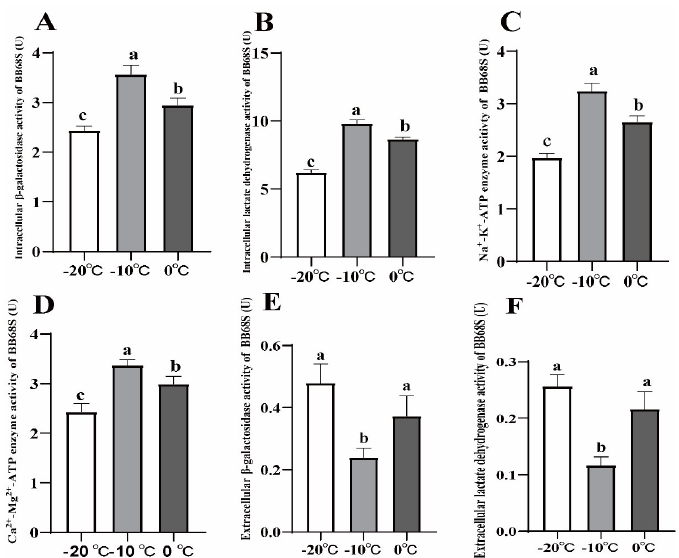
Figure 4. Intracellular β − galactosidase ( A ), intracellular lactate dehydrogenase ( B ), Na + - K + - ATP ( C ), Ca 2+ - Mg 2+ - ATP ( D ), extracellular β - galactosidase ( E ) and extracellular lactate dehydrogenase ( F ) activities of Bifidobacterium longum BB68S exposed to various sublimation temperatures. Different letters indicate significant differences ( p < 0.05). The SEM of BB68S obtained under different sublimation temperatures are shown in Figure 5. The intact cells maintained a smooth surface with a typical rod shape, in which most of the cell morphology was intact and full, no deformed cells were found, and there was no adhesion between cells.